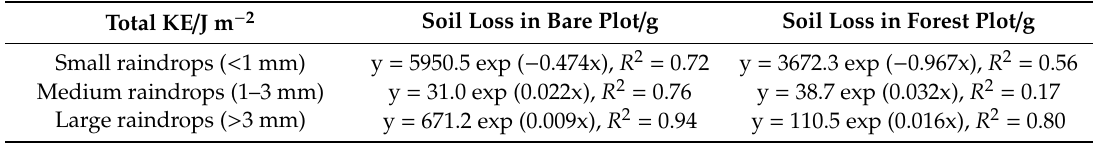
Table 5. The correlation between the KE of different classes of raindrops and soil loss.